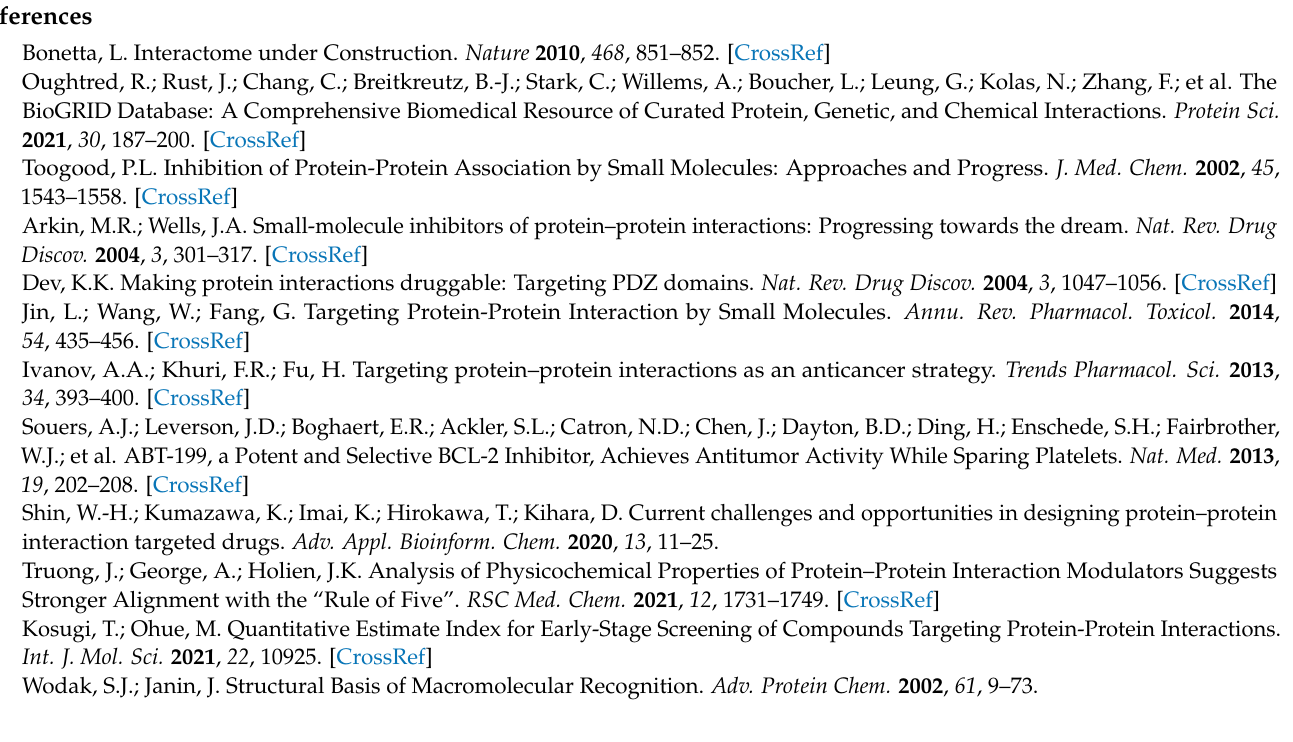
a solubility index; Figure S6: All top rank models from competitive peptide binding prediction of MDM2 with p53 and our highest affinity peptide consistently indicate the highest affinity peptide as the strong binder; Figure S7: Heatmap of all pLDDT values in predictions of competitive peptide binding of the competitor peptide and p53 peptide with MDM2 using ColabFold; Table S1: Values of each solubility index; Table S2: Normalized solubility indices used as solubility loss for AfDesign; Table S3: Sequences designed by AfDesign using Solubility-Weighted Index as a solubility index; Table S4: Sequences designed by AfDesign using Hydropathy Index as a solubility index; Table S5: Sequences designed by AfDesign using Hydrophobicity Index as a solubility index; Table S6: Sequences designed by AfDesign without a solubility index; Table S7: QPlogS and binding affinity for PDIQ and p53 peptide; Table S8: Sequences filtered by logS and Affinity thresholds for PDIQ + ‘N’; Table S9: RMSD of p53 peptide and the competitor peptide in the prediction of competitive binding using